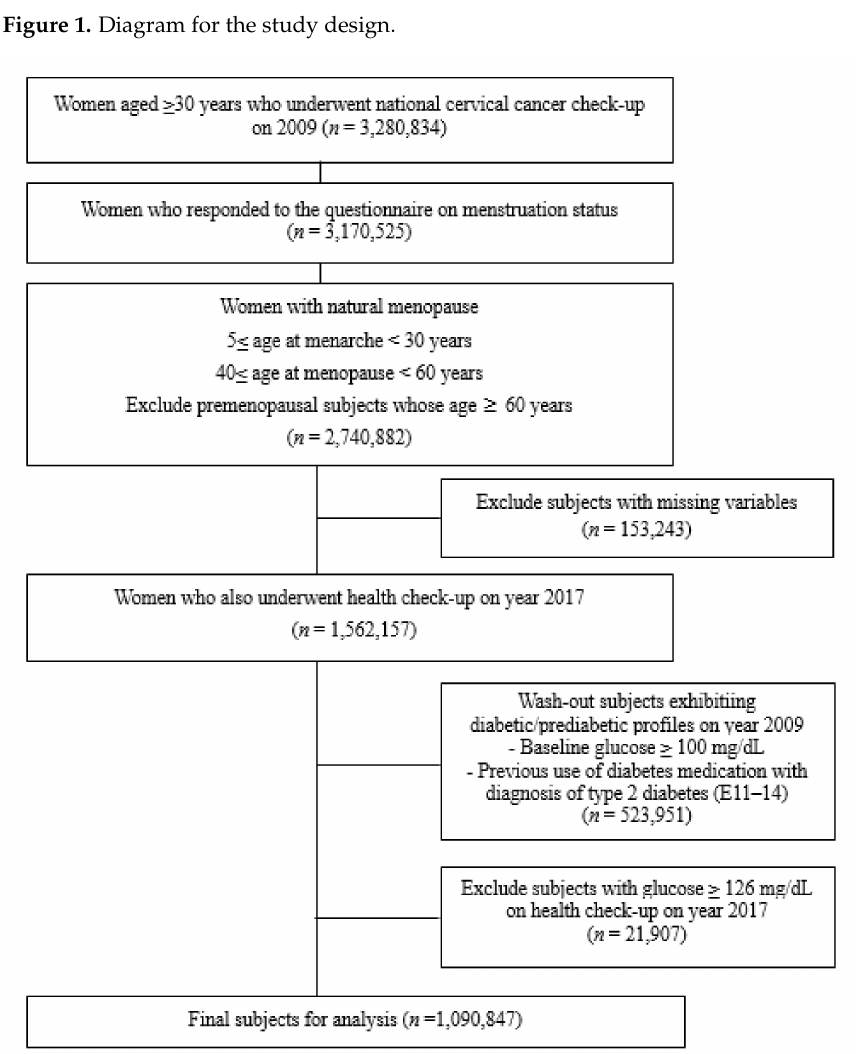
Figure 2. Flowchart for the selection of study